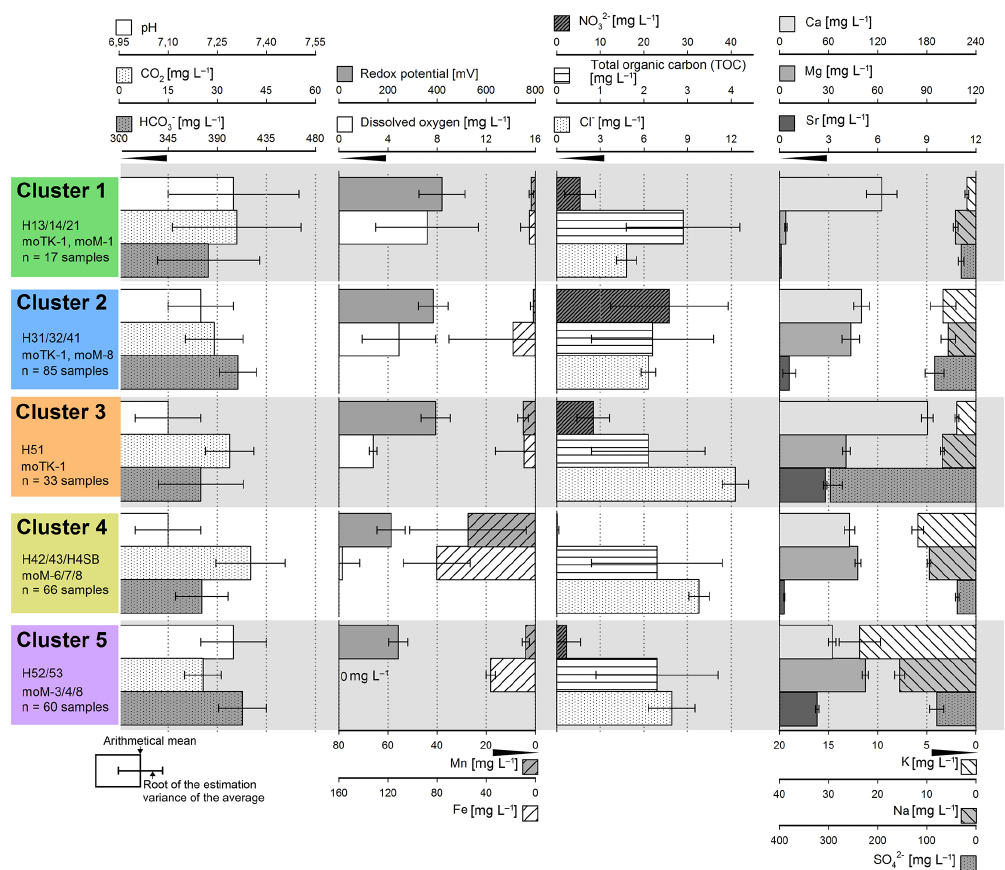
Figure 9. Average groundwater chemistry of hierarchical clusters 1–5 (left: groundwater wells and aquifer storeys within the clusters). First column: parameters related to the carbonate–CO 2 equilibrum; second column: dissolved O 2 , redox potential and redox-sensitive ions; third column: ions which are potentially related to land management; fourth column: ions related to the dissolution of either carbonate/sulfate or clay minerals. The colour code of hierarchical clusters is identical to Fig.